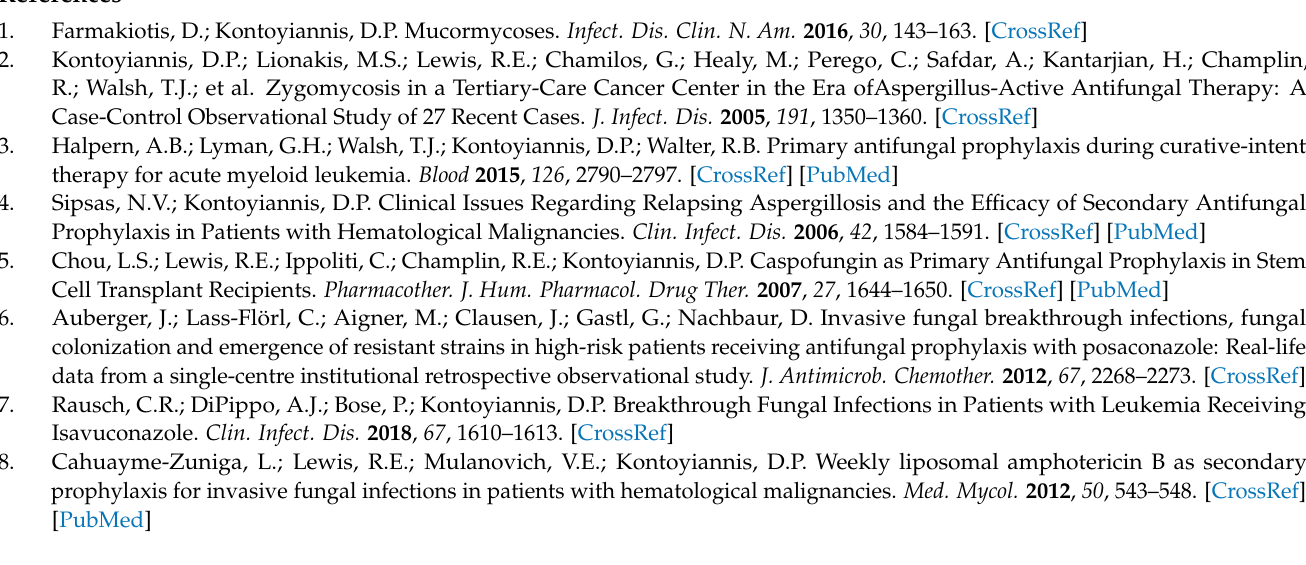
drugs. Figure S3: Kaplan–Meier curves of progression to all-cause 42-day and 84-day mortality of breakthrough mucormycosis, depending on the year of